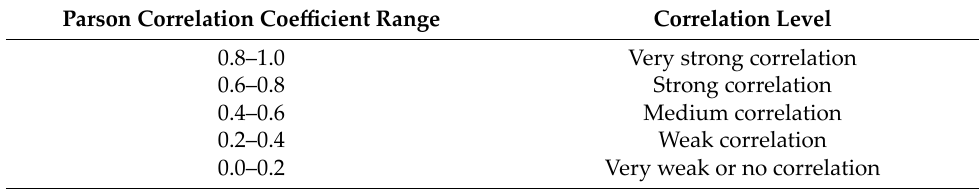
Table 1. Pearson correlation coefficient standard.